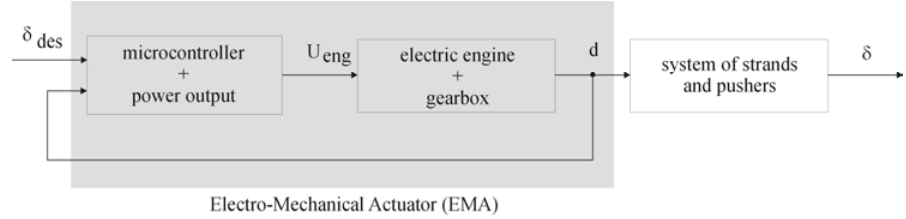
Fig 2 . Simple block scheme of EMA